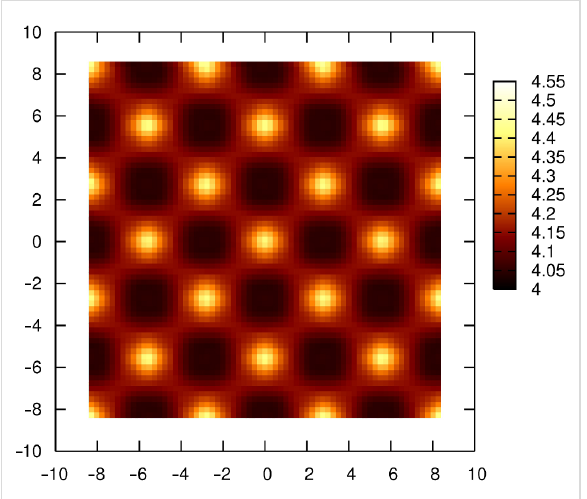
Figure 4: Constant-frequency-shift image ( Δ f = − 60 Hz) of the NaCl surface imaged with the cluster Cr tip.